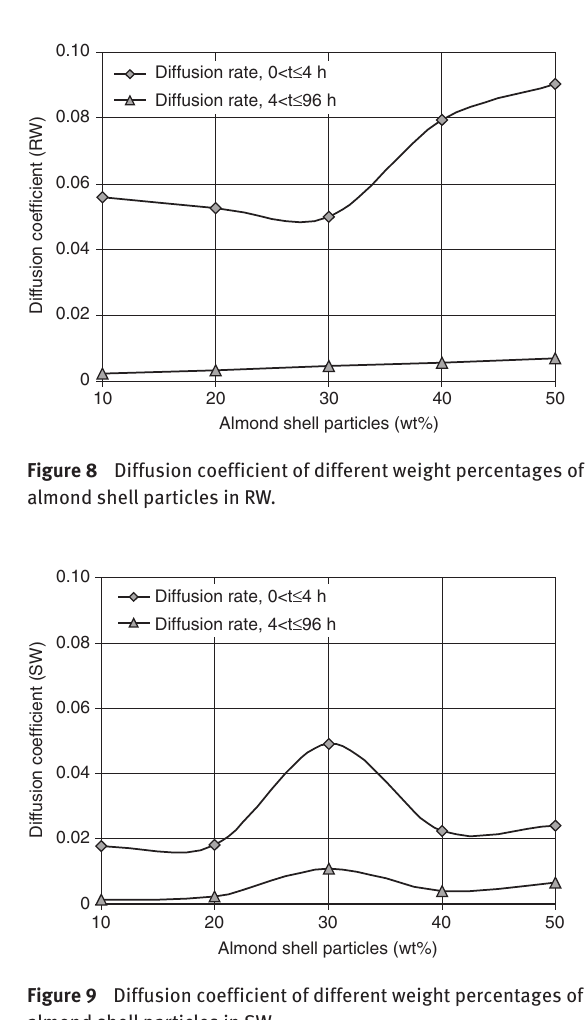
Figure 9 Diffusion coefficient of different weight percentages of almond shell particles in